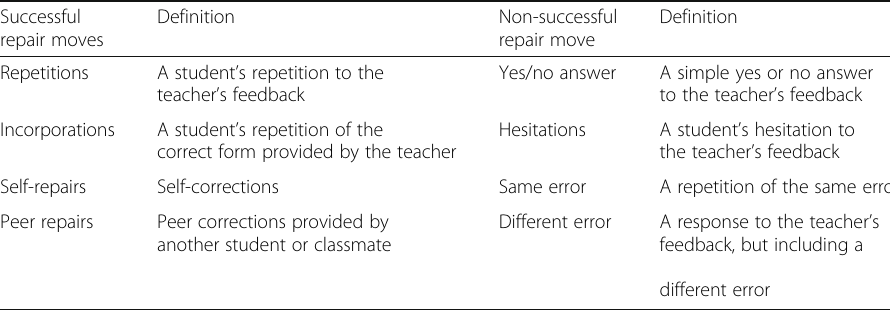
Table 3 Successful and non-successful repair moves and what they refer to according to Lyster and Ranta